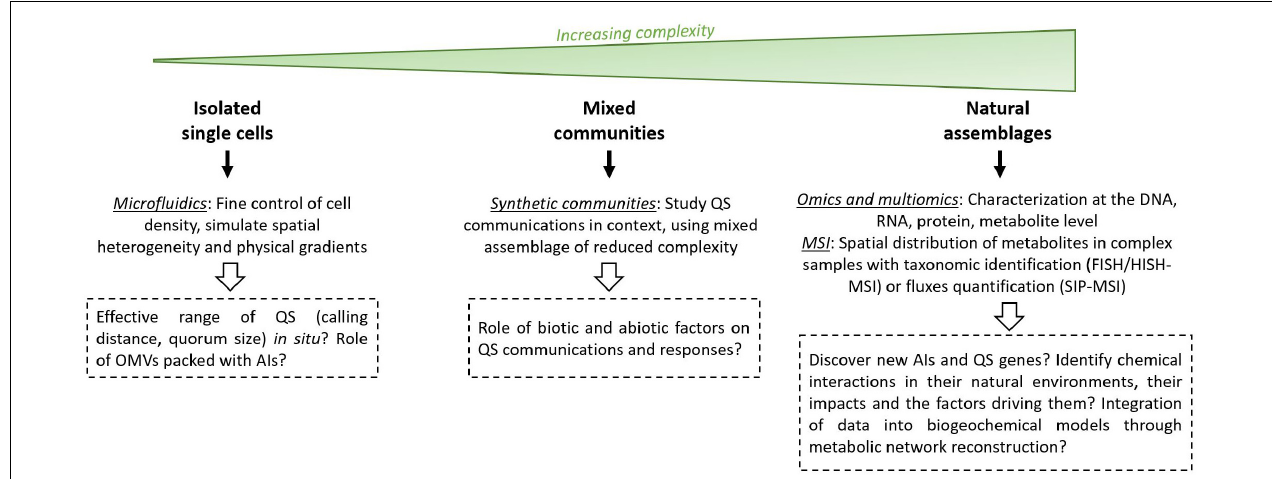
FIGURE 5 | Future perspectives and new tools in QS studies. AI, autoinducer; OMVs, outer membrane vesicles; MSI, mass spectrometry imaging; FISH, fluorescence in situ hybridization; HISH, halogen in situ hybridization; SIP, stable isotope probing.